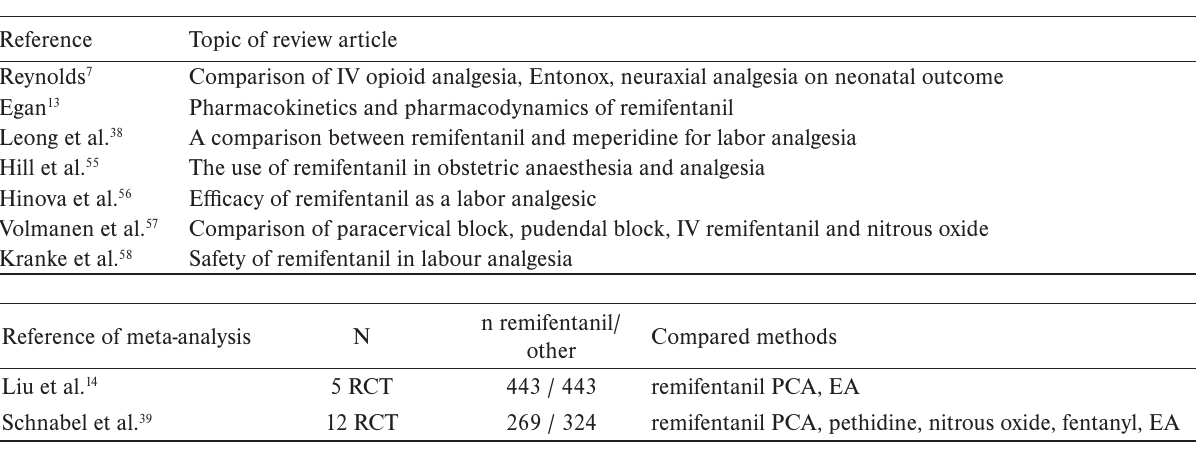
Table 2. Review articles on remifentanil or other alternative labour analgesia and a meta-analysis of randomised controlled